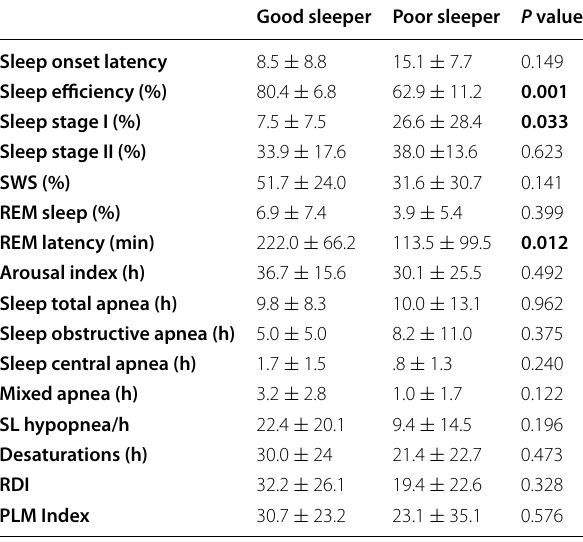
Table 4 Comparison between the good and bad sleepers groups as regards polysomnographic